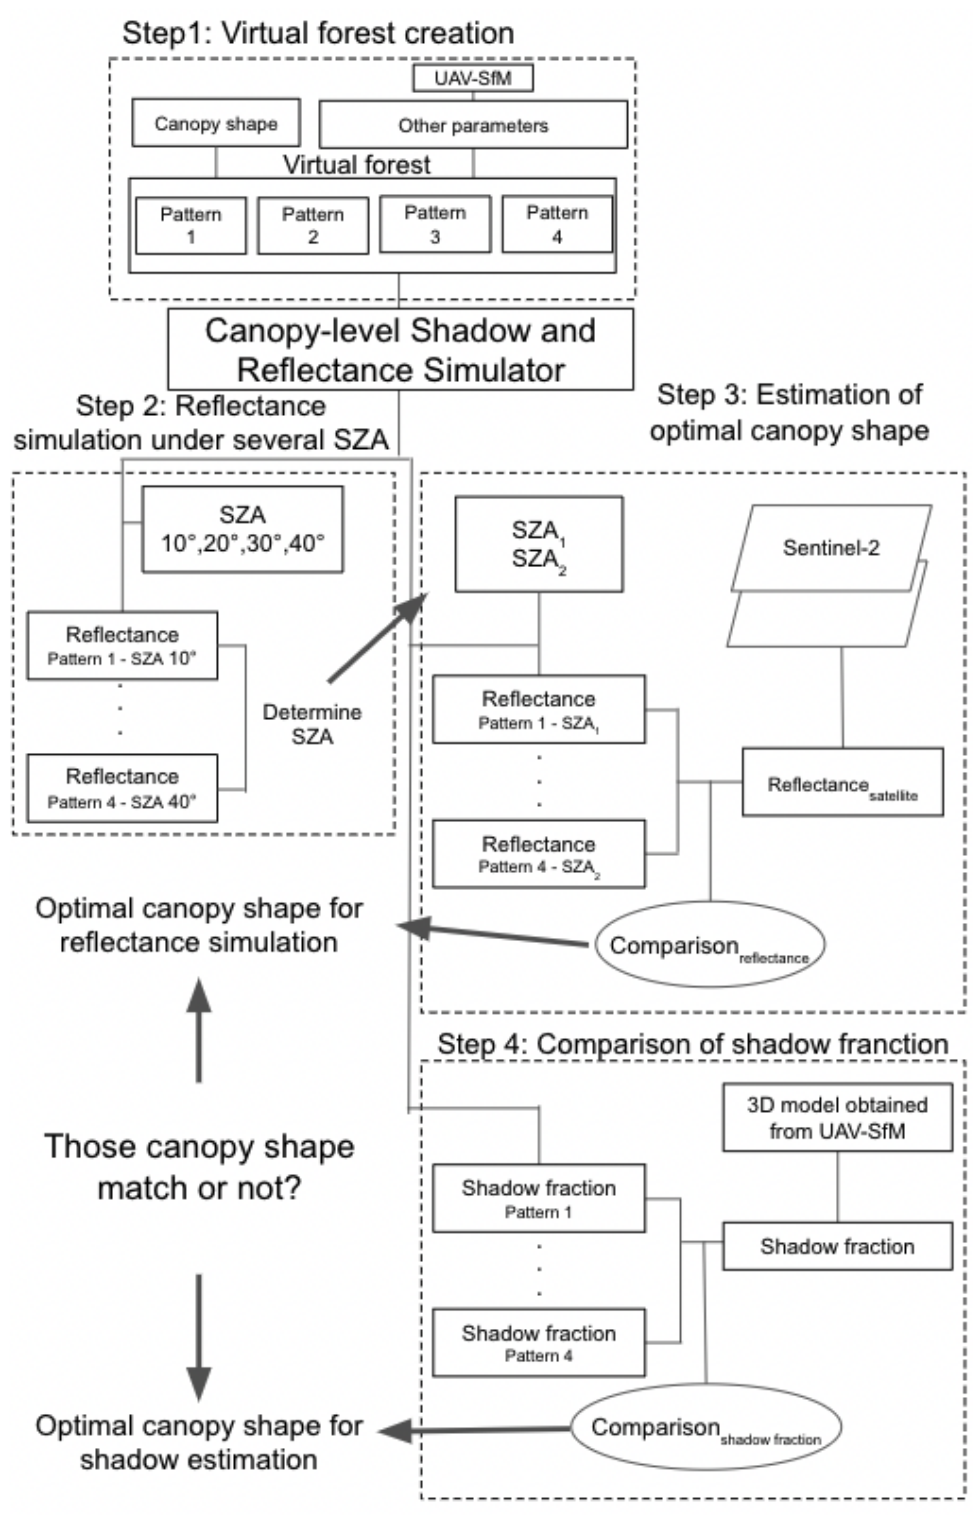
Figure 3. Overall flowchart of this